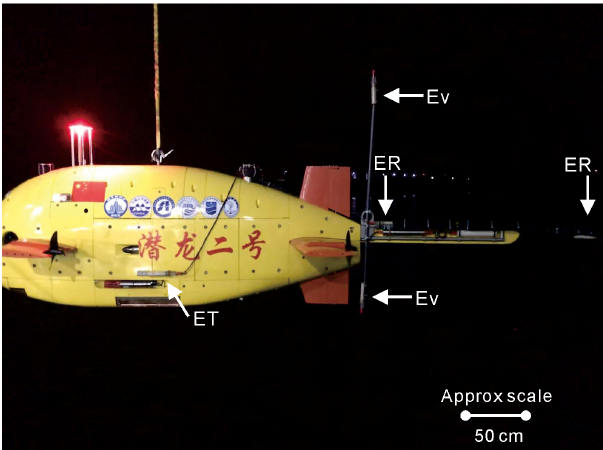
Figure 1. Layout of each channel electrode on the AUV. E R is the inline horizontal component of the electrical field recorded by chan- nels 1 and 2. E T is the crossline horizontal component of the electri- cal field recorded by channels 3 and 4. E V is the vertical component of the electrical field recorded by channels 5 and